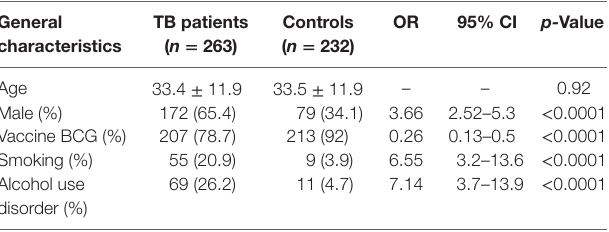
TaBle 1 | Baseline characteristics of patients with TB and the healthy controls.